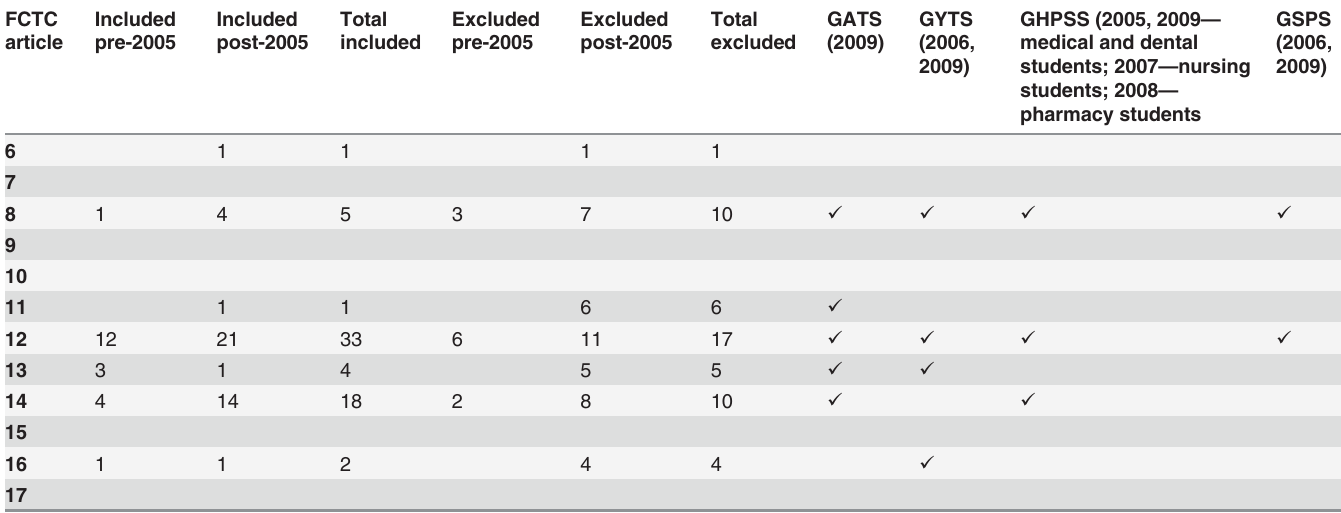
Table 3. Summary of studies identified by FCTC